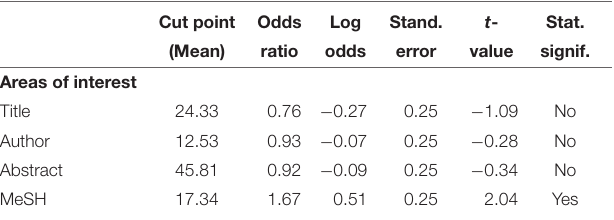
TABLE 3 | Summary of the relationship between number of queries issued and gaze (N number of queries issued = 256, N eye gaze = 256; statistical significance at 95%).